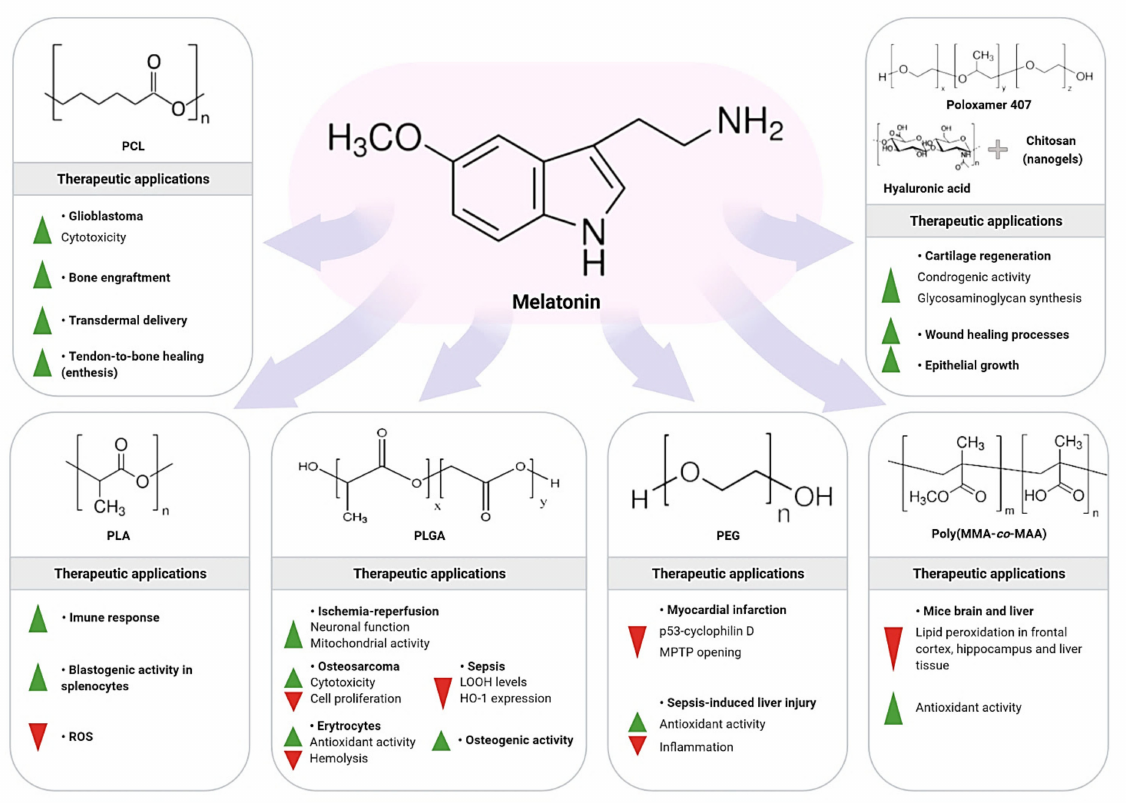
Figure 3. Melatonin incorporated into synthetic polymeric NPs or nanogel as NC provides a favorable biological response in different cells and damaged tissues. These activities are especially attributed to its antioxidant, anti-inflammatory, antitumor, and regenerative properties, in addition to the regulation of mitochondrial dynamics. PCL: polycaprolactone, PLA: poly-lactic acid, PLGA: poly (lactic-co-glycolic acid), PEG: polyethylene glycol, Poly (MMA- co -MAA): poly (methyl methacrylate- co -methacrylic acid). Green arrow = increased action, Red arrow = decreased action. Image was created using Biorender.com. Access in February